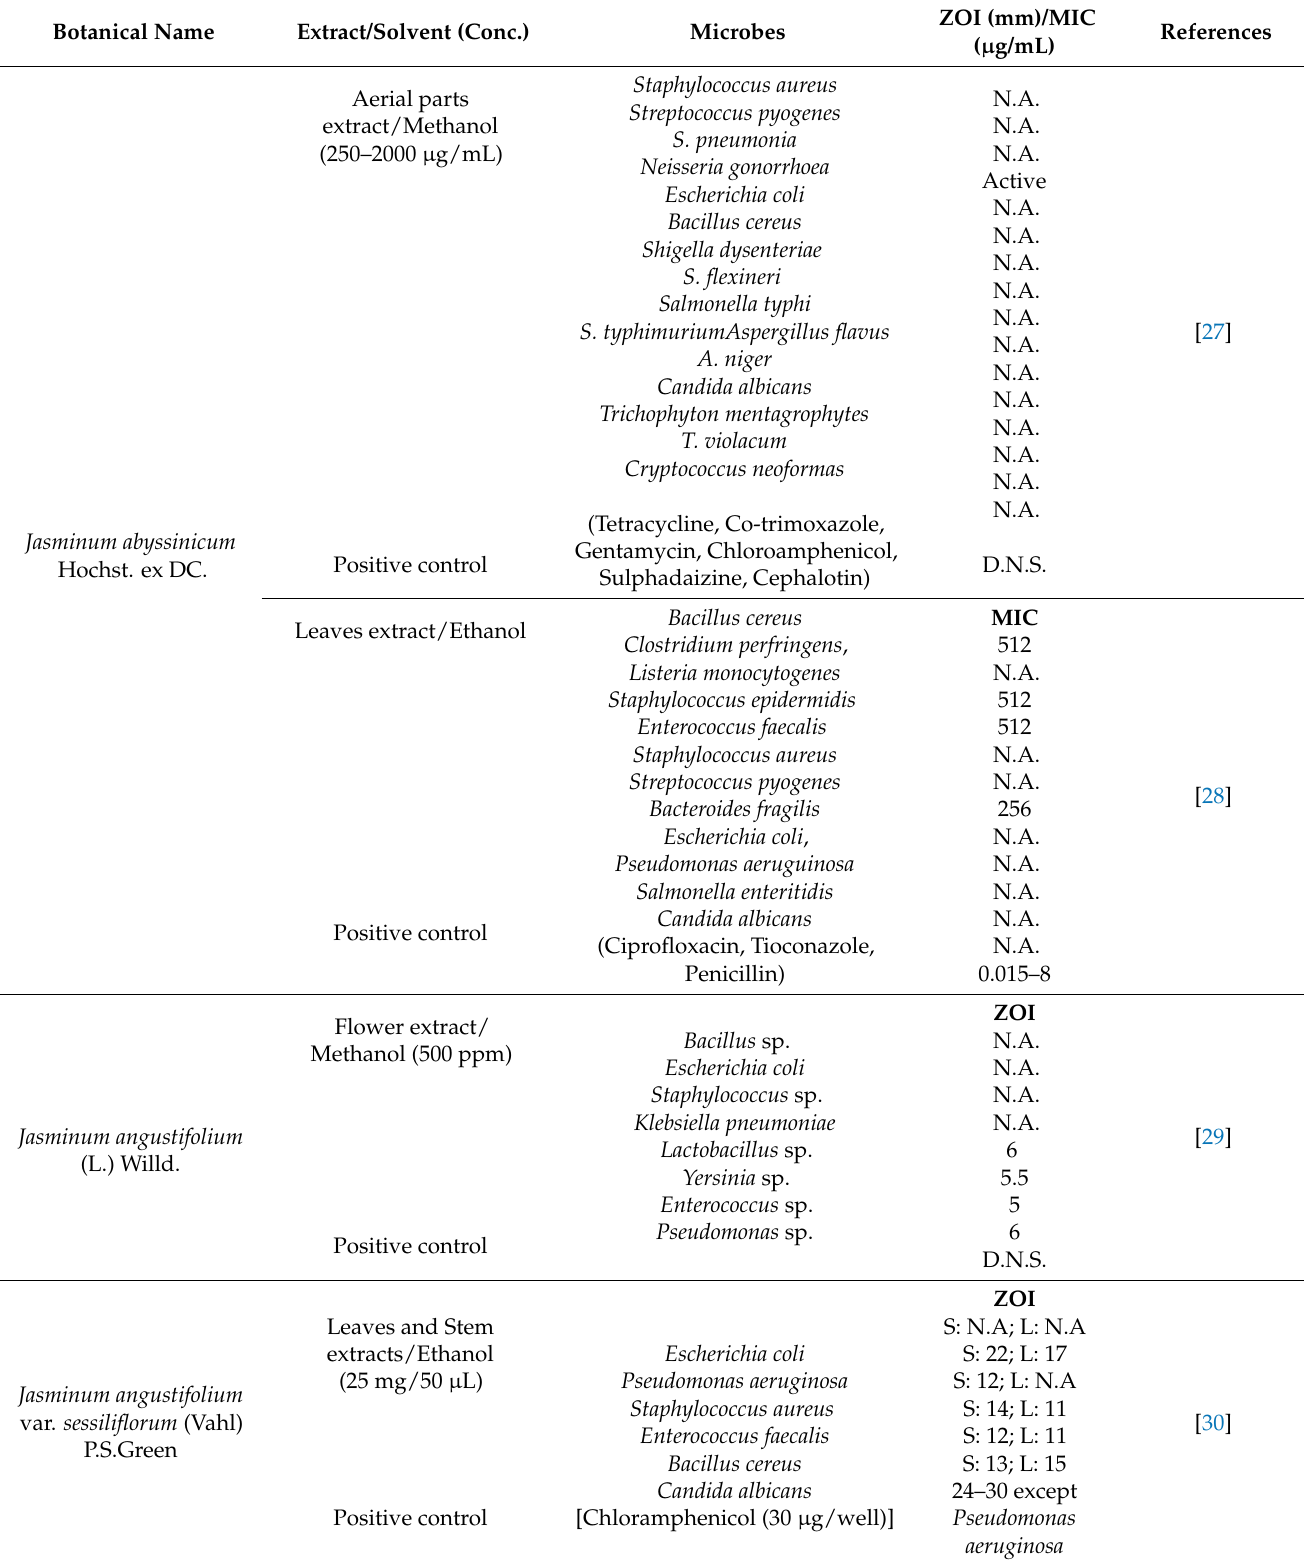
Table 1. Antimicrobial potential of Jasminum